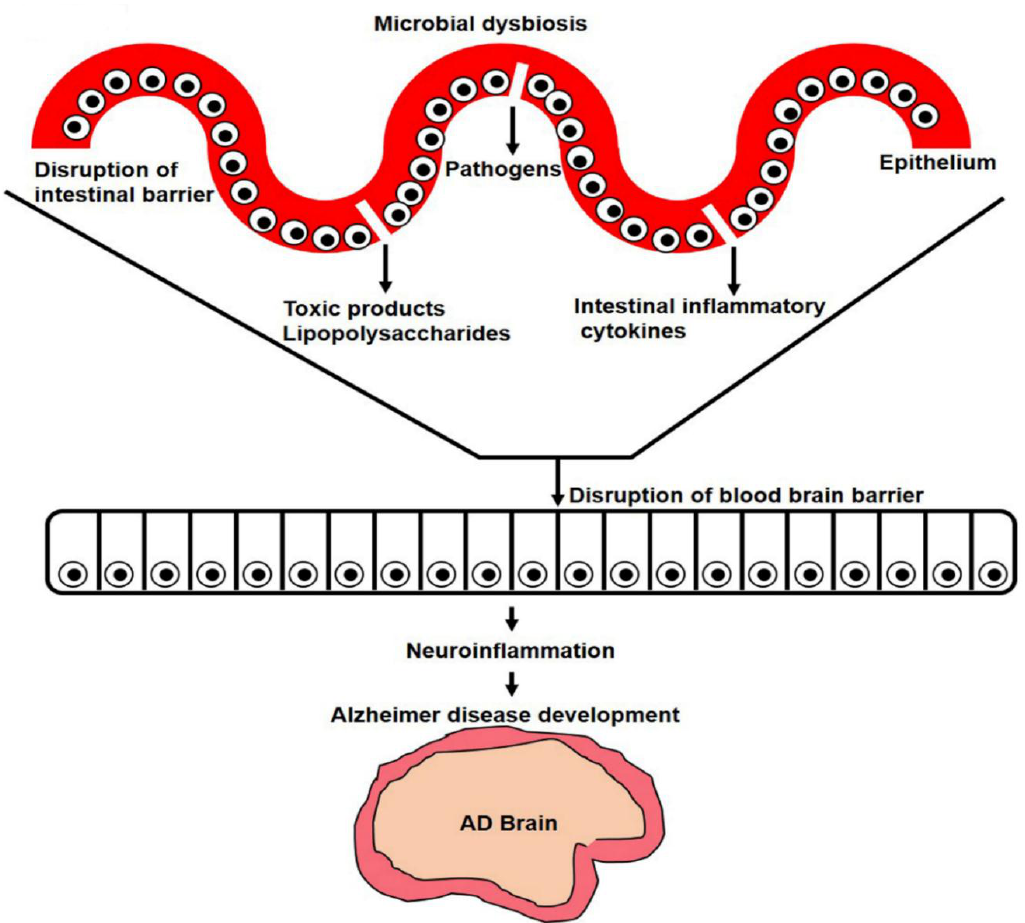
Figure 6. Gut-microbiota-secreted polysaccharides and other toxins cause neuroinflammation and Alzheimer’s disease development. When circulatory lipopolysaccharides enter the brain, it activates inflammatory pathways and increases the number of reactive microglia. Increased inflammatory cytokines and NF- κ B increase APP and amyloid beta protein cleavage and accumulation, and cause Alzheimer’s disease development.